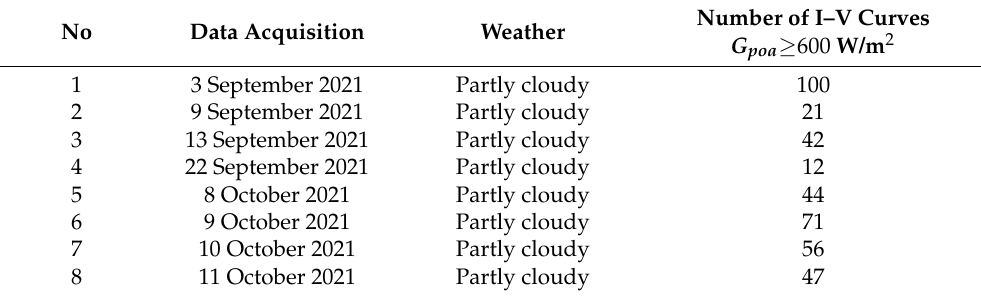
Table 13. Data for the validation of the hybrid PV